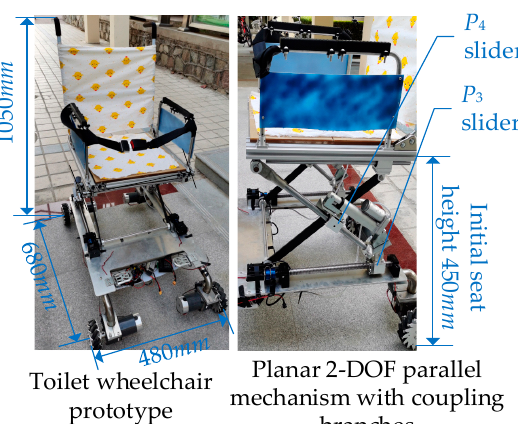
Figure 16. Principle prototype of the intelligent toilet wheelchair.